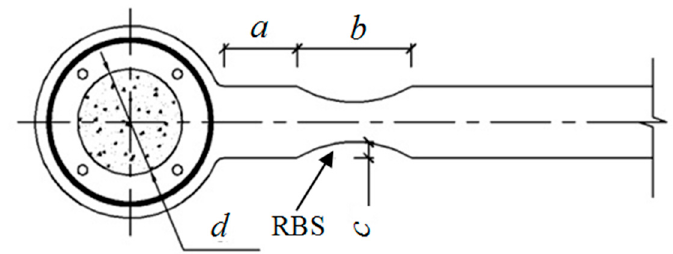
Figure 1. The detail of the innovative joint (RBS, reduced beam section).